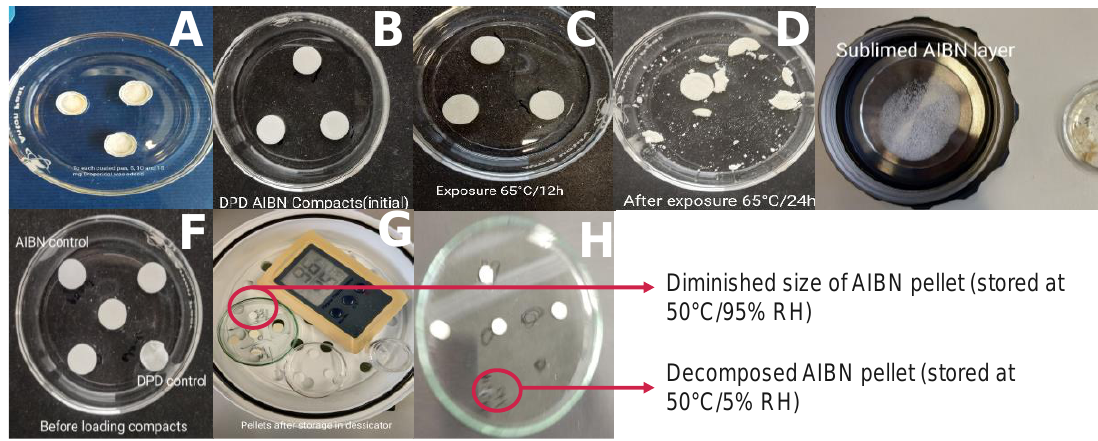
Figure 2. Images showing autoxidation approaches with DPD:AIBN (1:1) pellets exposed to different conditions. ( A ) Feasibility approach with AIBN layer topped with DPD in DSC pans before exposure in RapidOxy ® ; ( B ) original appearance of DPD:AIBN pellet before exposure in RapidOxy ® ; ( C ) appearance of pellets after exposure in RapidOxy ® (65 °C/12 h/400 kPa); ( D ) disintegrated pellets after exposure in RapidOxy ® (65 °C/24 h/400 kPa); ( E ) AIBN layer deposited on the lid (left) and disintegrated pellets (right) after exposure in RapidOxy ® (65 °C/120 h/400 kPa); ( F ) original appearance of pellets before exposure in the oven; ( G ) appearance of pellets after exposure in the oven (50 °C/95% RH/240 h); ( H ) Appearance of pellets after exposure in the oven (50 °C/5% RH/240 h).